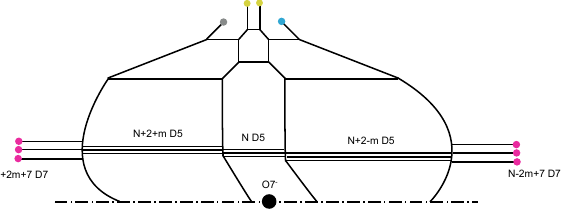
Figure 29 . The 5-brane web diagram realizing the 5d Sp( N +2) write the web diagram for the case with n = 2 for simplicity. This web diagram can be obtained by pulling all the 7-branes outside the 5-brane loops from the con(cid:12)guration depicted in (cid:12)gure 28 with n =